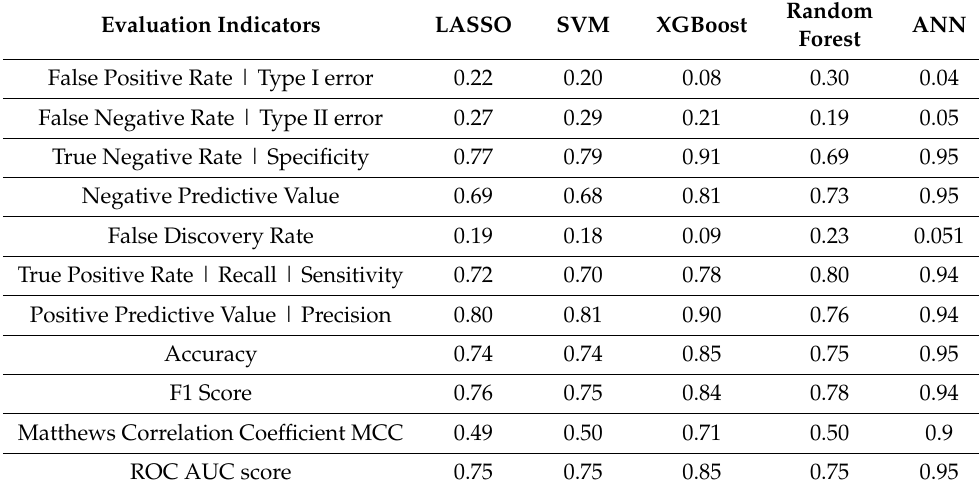
The classification accuracy was visualized using receiver operator characteristic (ROC) plots for all the models and all showed an area under the curve (AUC) > 75%, with ANN returning the maximum AUC of 95% (Figure 4).